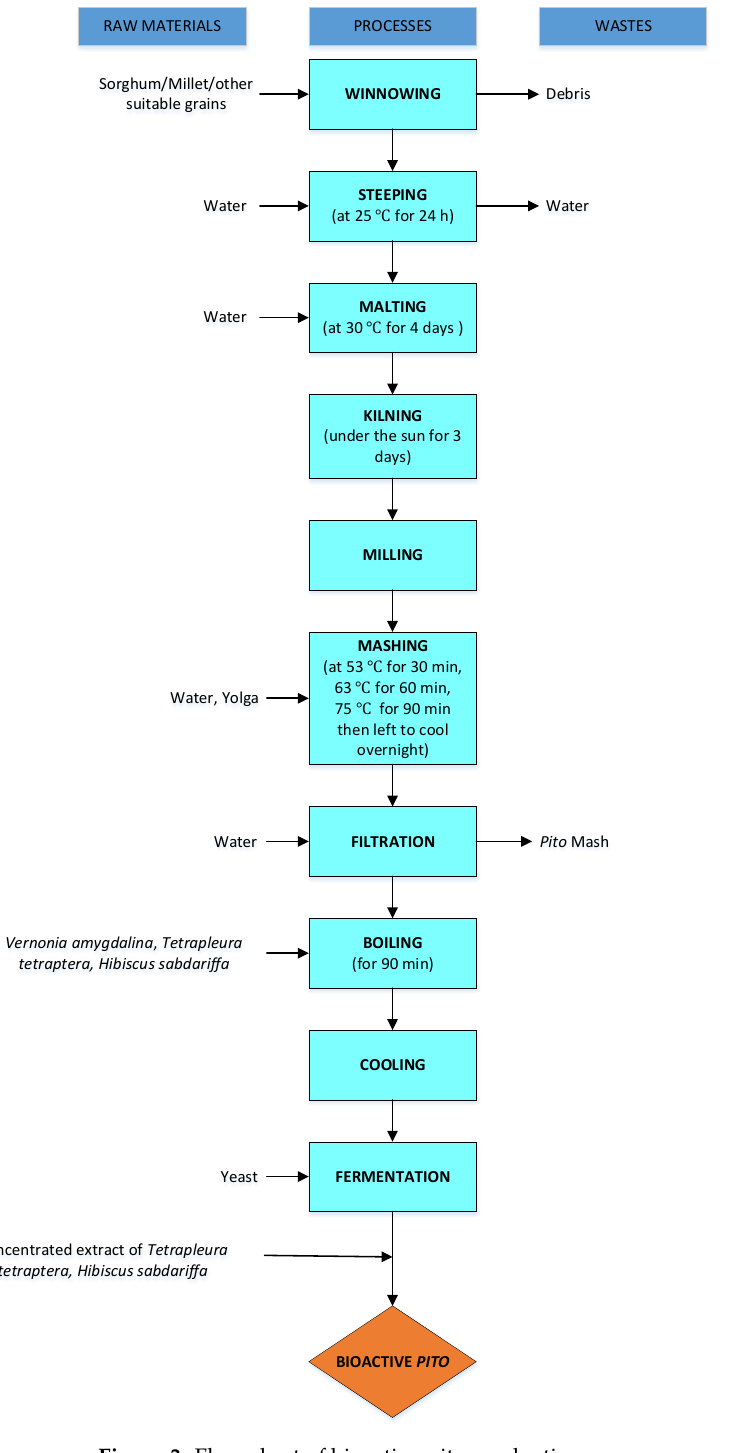
Figure 3. Flow chart of bioactive pito production.